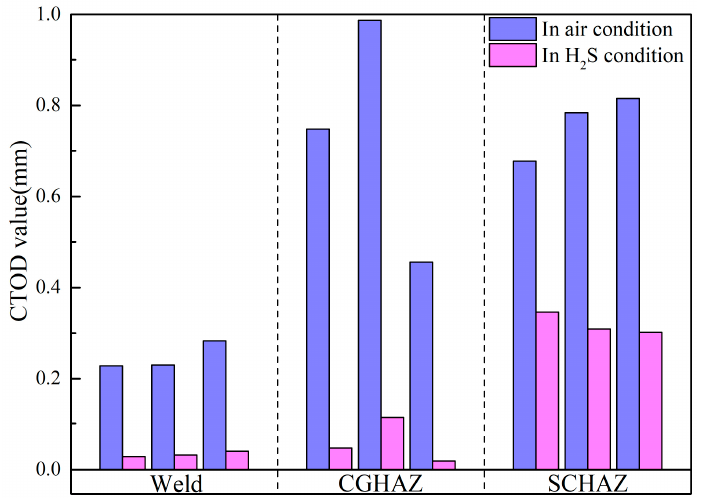
Figure 7. CTOD characteristic values.